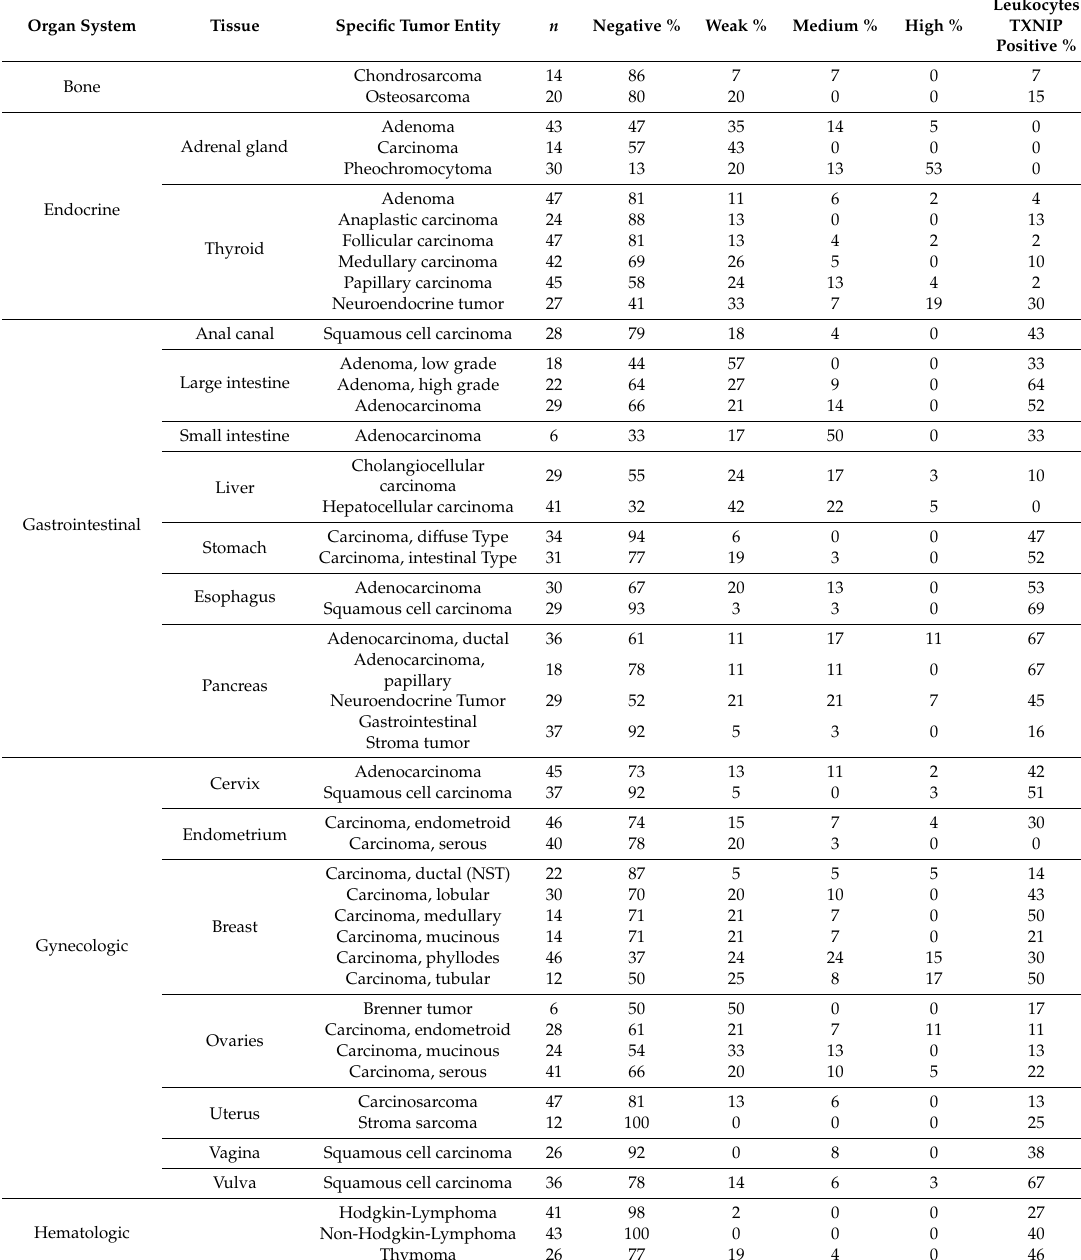
Table 1. Immunohistochemical detection of thioredoxin interacting protein (TXNIP) in a multi-tumor tissue